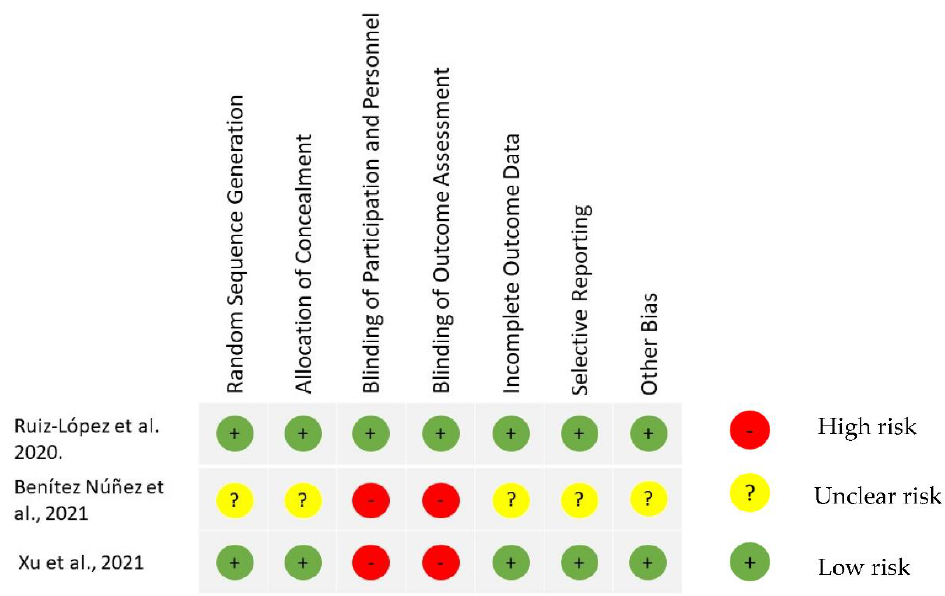
Figure 2. Risk of bias summary of the RCT- studies based on authors’ judgements of each item.